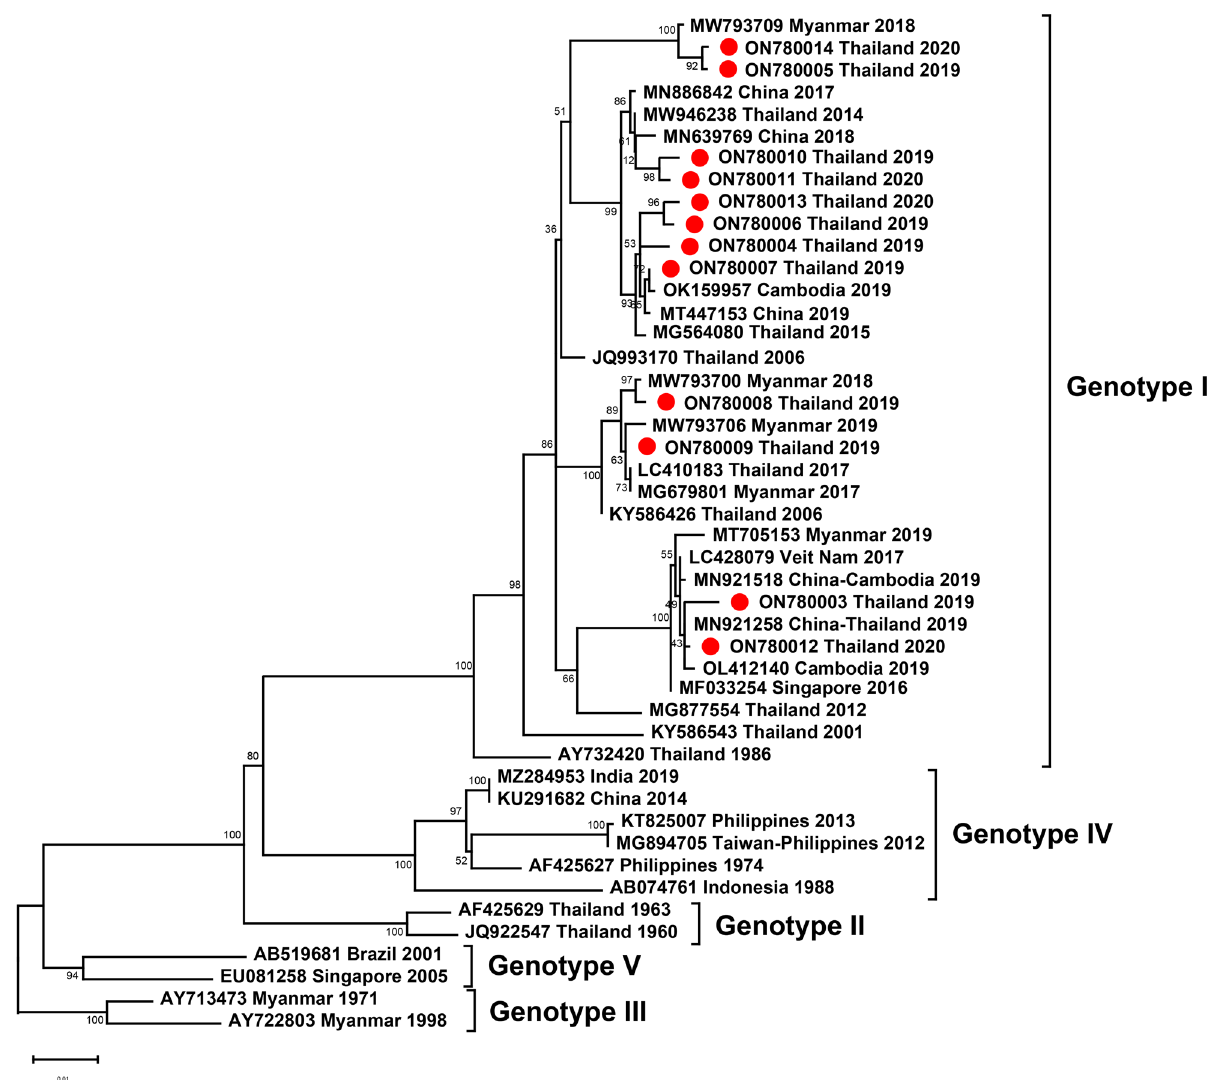
Figure 4. Phylogenetic analysis of DENV-1. The maximum-likelihood tree of DENV-1 was constructed from partial E gene sequences (1362 nucleotides) of DENV-1 Thai strains isolated in this study and strains selected from the GenBank database. The tree was generated using the TIM2 + F + G4 model with 1000 ultrafast bootstrap replicates. Bootstrap values are indicated at branch nodes. Red dots denote DENV Thai strains from this study. Black brackets on the right indicate DENV-1